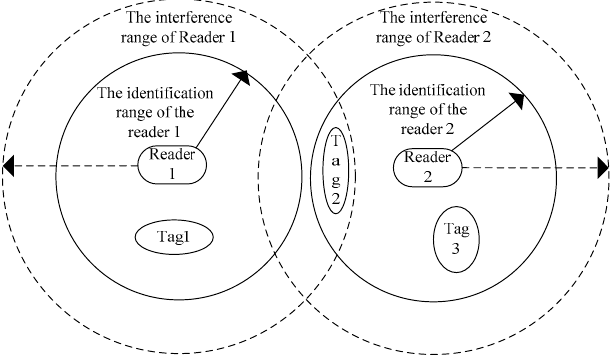
Figure 3. Reader-reader collision diagram.